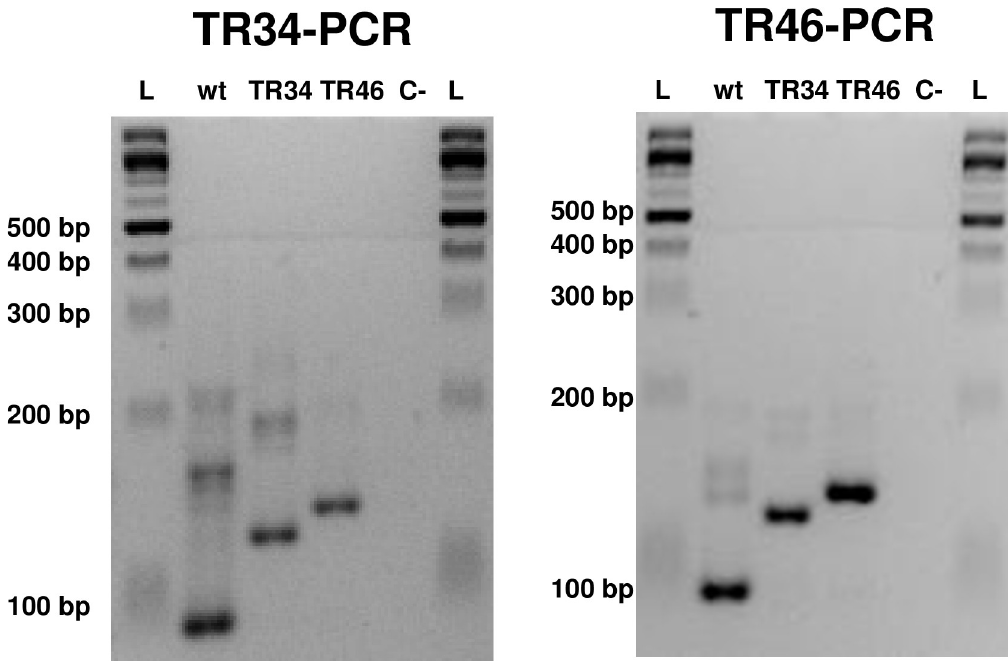
Fig 4. The nested TR34-PCR and TR46-PCR assays amplify A . fumigatus wild type (wt) alleles and the TR 34 and TR 46 alleles. Differentiation among these alleles can be accomplished with electrophoresis in 4% high-definition agarose. https://doi.org/10.1371/journal.pone.0282499.g004 33) of the samples and one (3.0%) had the TR allele. Five samples (nos. 6, 8, 18, 20, and 21) 46 were positive for wt A . fumigatus by both assays. Sample results were not always consistent between replicates or between assays. For example, sample nos. 30 and 31 each have one posi- tive resistance allele (TR ) in one replicate for the TR-34 assay and are negative for the other 46 replicate and are both negative for both replicates for the TR-46 assay (Fig 3). When the sam- ples positive for a TR allele were electrophoresed using the high-definition 4% agarose it showed that these 10 samples had the TR allele. These included 8 air, soil, and plant debris 46